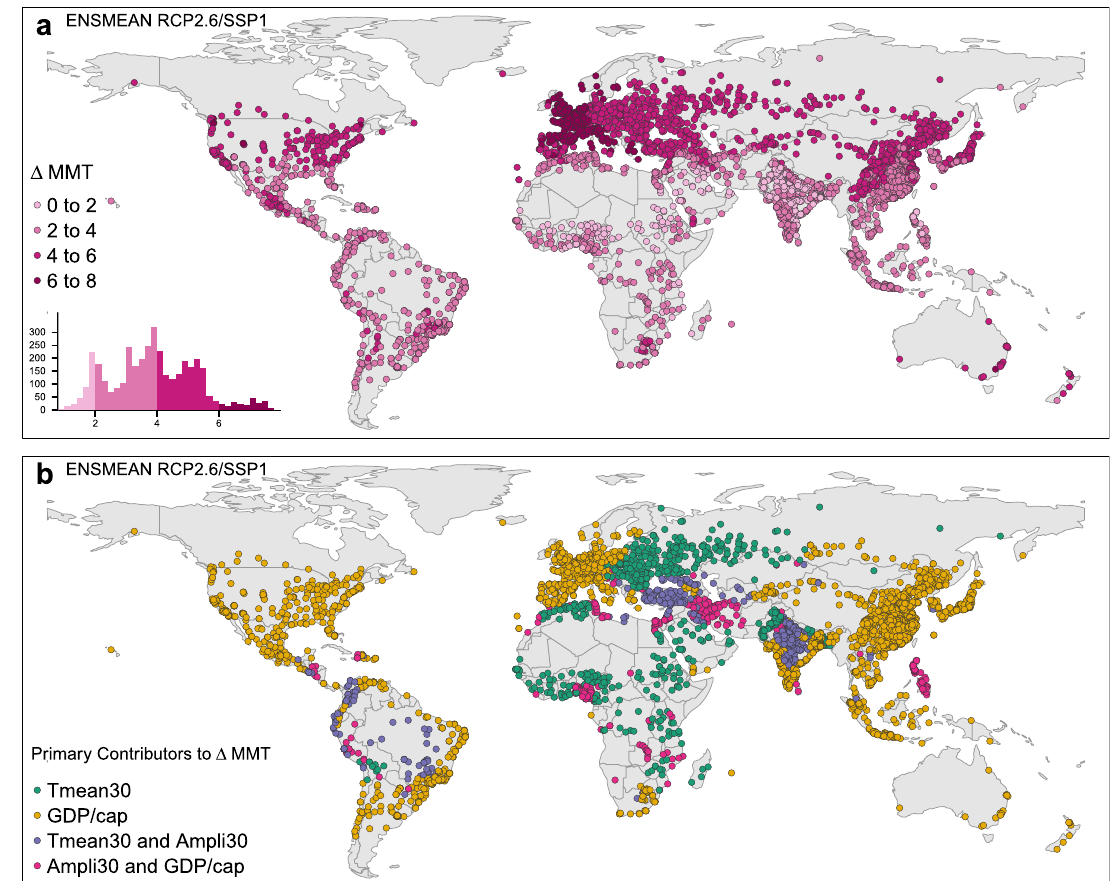
Figure 3. Changes in adaptation until 2100 and their primary contributors to (cid:31) MMT in a RCP2.6/SSP1 future. (cid:31) MMT 2000–2100 for RCP2.6/SSP1 for major world cities ( a ). Contributions of the single variables’ 2000–2100 changes to (cid:31) MMT 2000–2100 for RCP2.6/SSP1 ( b ). (Map created in R (version 3.6.2) 28 using the tmap package (version 2.3-2) 29